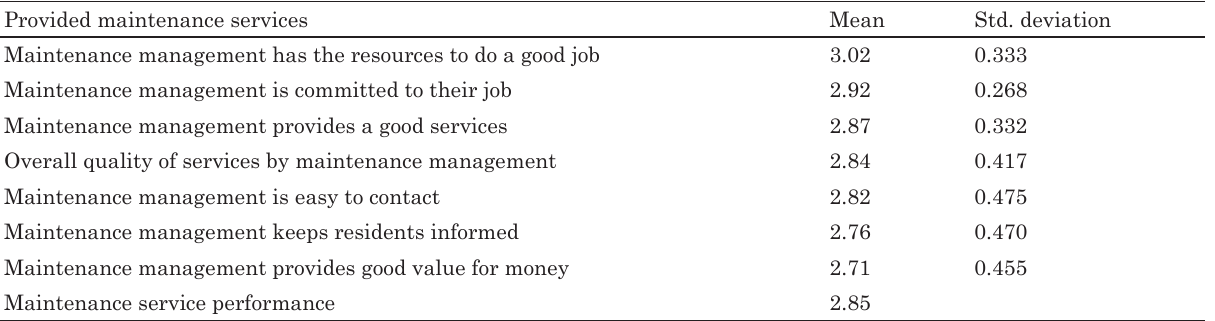
Table 2. Performance of maintenance services from residents’ perception Provided maintenance